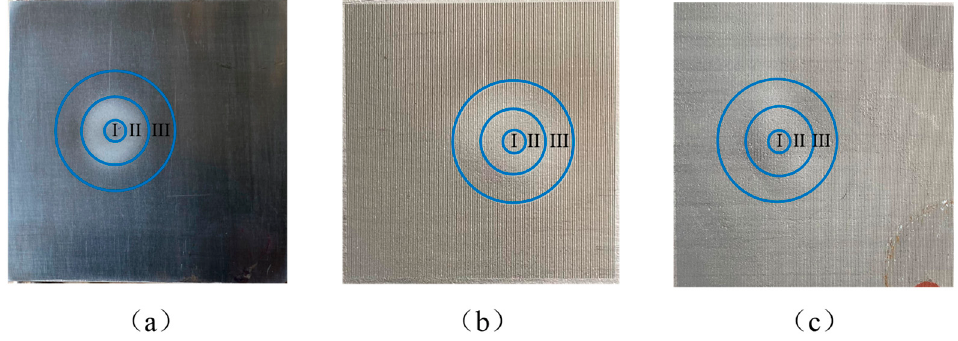
Figure 8. Schematic diagram of three areas after erosion: ( a ) untreated surface; ( b ) superhydrophobic surface; ( c ) superhydrophilic surface.